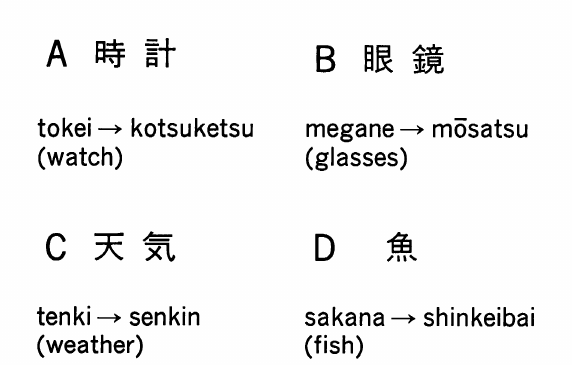
FIG. 1. Neologistic oral reading of Kanji words. The neologistic oral reading was unrelated to the phonetiC forms inherent to each kanji character, i.e on- and kun-readings (e.g. in D, the term "sakana" is the kun-reading, and "gyo" the on-reading). Behavioural Neurology. Vol 5 .